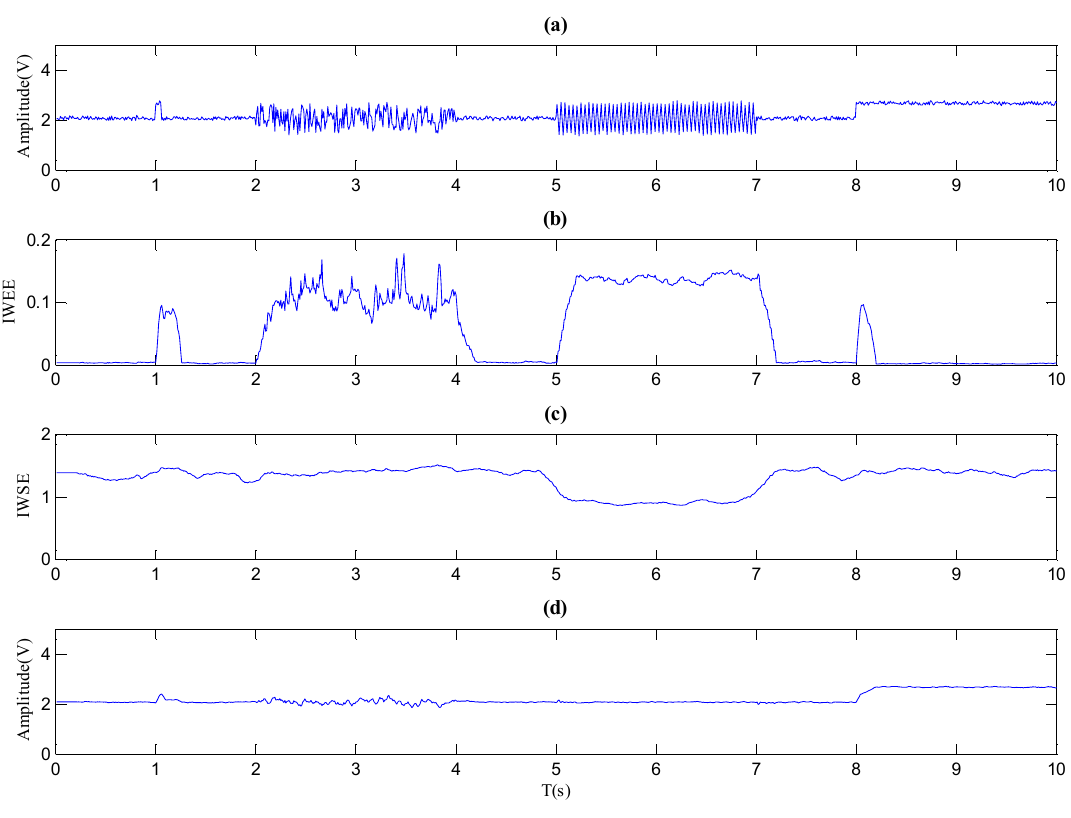
Figure 1. Results of the numerical simulations. (a) Signal with four kinds of